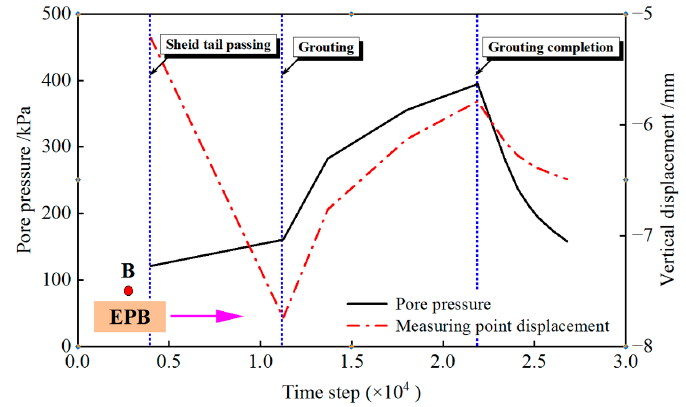
Figure 10. Grouting pressure and settlement at point B.